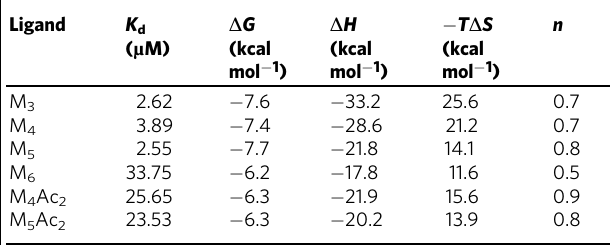
Table 2 Thermodynamic binding parameters of Ri MnBP to linear and decorated